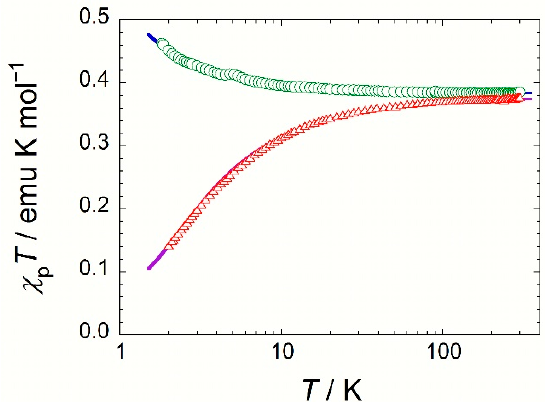
Figure 6. Temperature dependences of χ p T of 3-BTHIN (open triangles) and 3-BTHNN (open circles). Solid lines represent theoretical fitting on the basis of the 1D AFM Heisenberg model for 3-BTHIN and the quasi-2D FM Heisenberg model for 3-BTHNN (see the text).